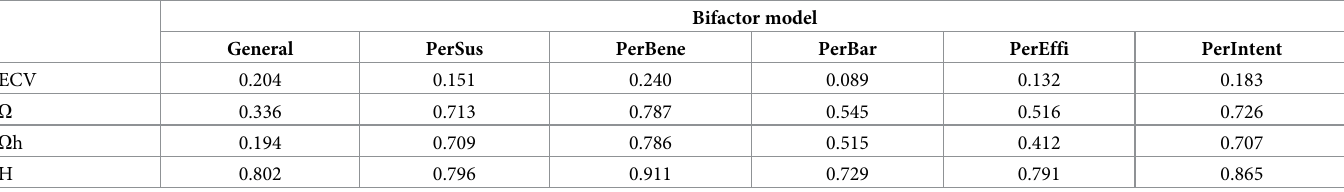
Table 7. Indicators of dimensionality and reliability of the bifactor model of